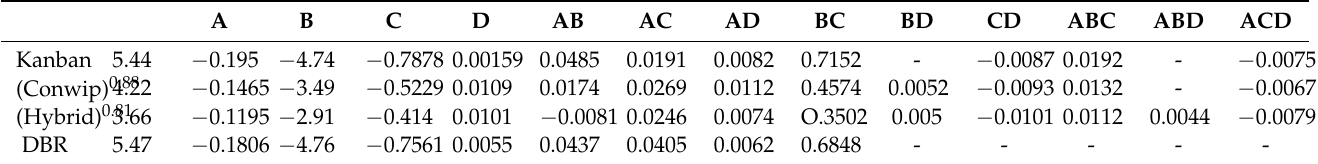
Table A5. Regression coefficient for coded factors.